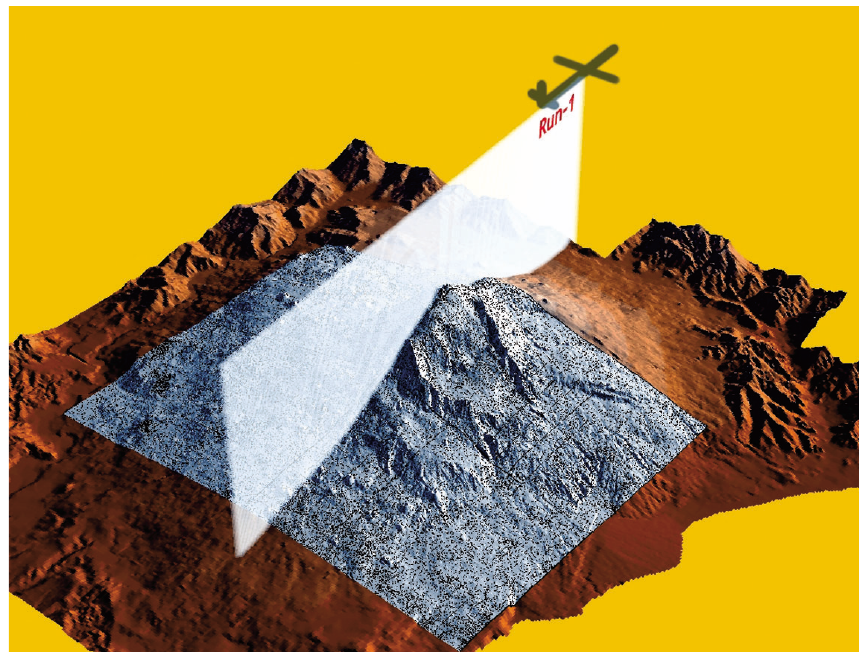
Fig. 1. Flying path of the MIVIS sensor installed on a CASA aircraft over Mt. Etna during the July 2001 erup- tive